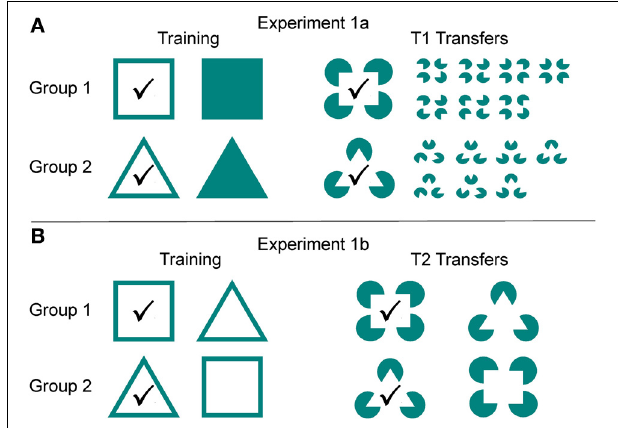
FIGURE 2 | Experiment 1. Shown are the stimuli that were presented to each group during regular training and transfer test trials in experiments 1a and 1b. The positive, rewarded stimulus is indicated by a checkmark. (A) In group 1 an empty square was the positive, rewarded stimulus, in group 2 it was an empty triangle. During the T1 transfer tests of experiment 1a, sharks were “expected” to choose the correct Kanizsa figure. (B) During experiment 1b, group 1 was trained to recognize an empty square over an empty triangle, whereas group 2 was trained vice versa. During the T2 transfer tests, sharks were expected to choose the Kanizsa figure resembling the stimulus they had been trained on.